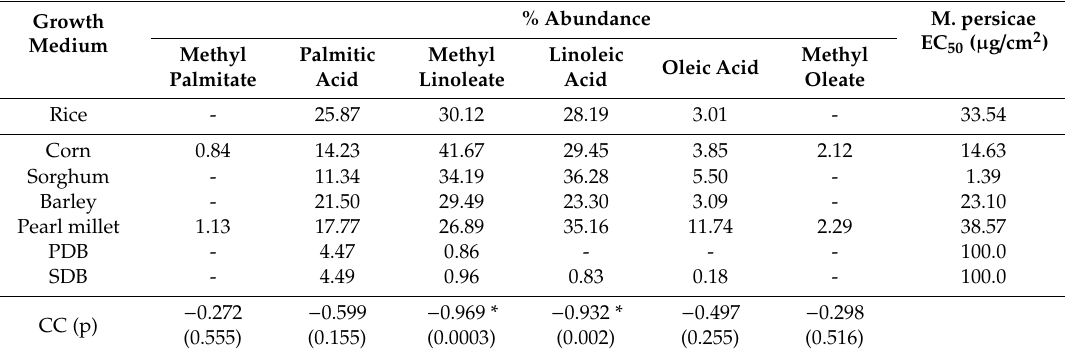
Table 7. Gas chromatography–mass spectroscopy (GC-MS) analysis of the di ff erent EFI 671 solid and liquid media extracts and correlation coe ffi cients (CC, p = significance level) with bioactivity (EC 50 in µ g / cm 2 for M. persicae